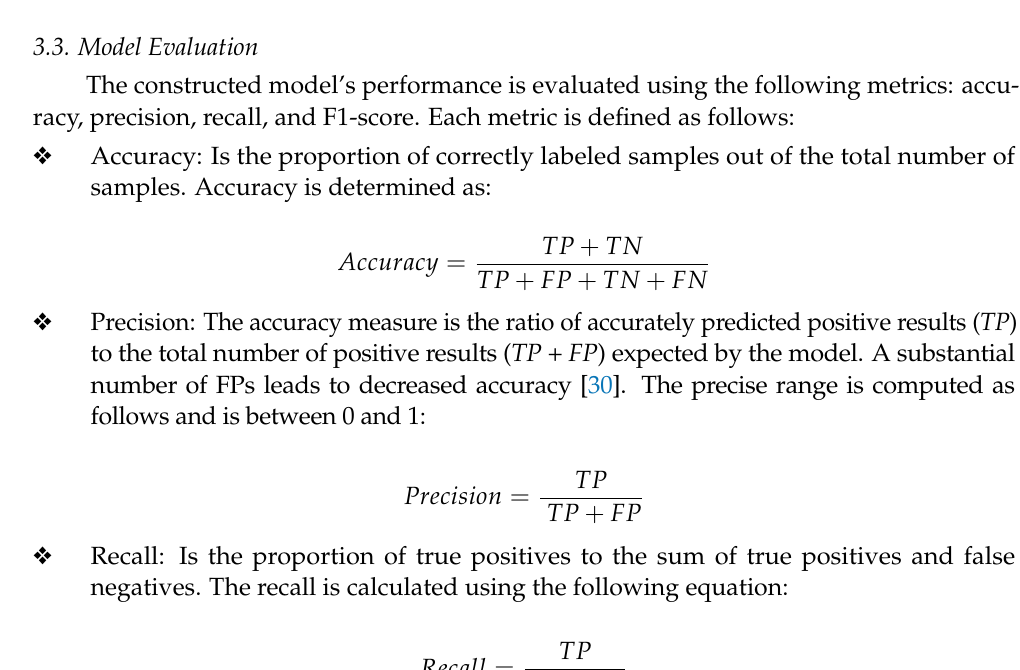
Figure 5. Yolov5L’s network architecture consists of three components: the backbone (CSPDarknet), the neck (PANet), and the head (Yolo Layer). The data is first passed through CSP Darknet for feature ex-traction, then through PANet for feature fusion, and finally through the Yolo Layer for the detection results.